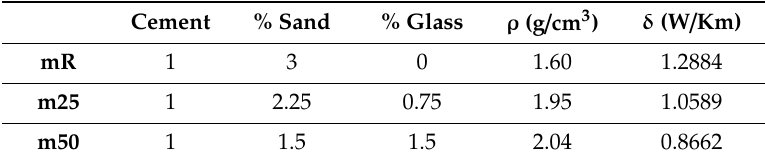
Table 1. Sand and glass composition of mortars used in the study, density of the end product ( ρ ), and thermal conductivity ( δ ) at 30 °C.